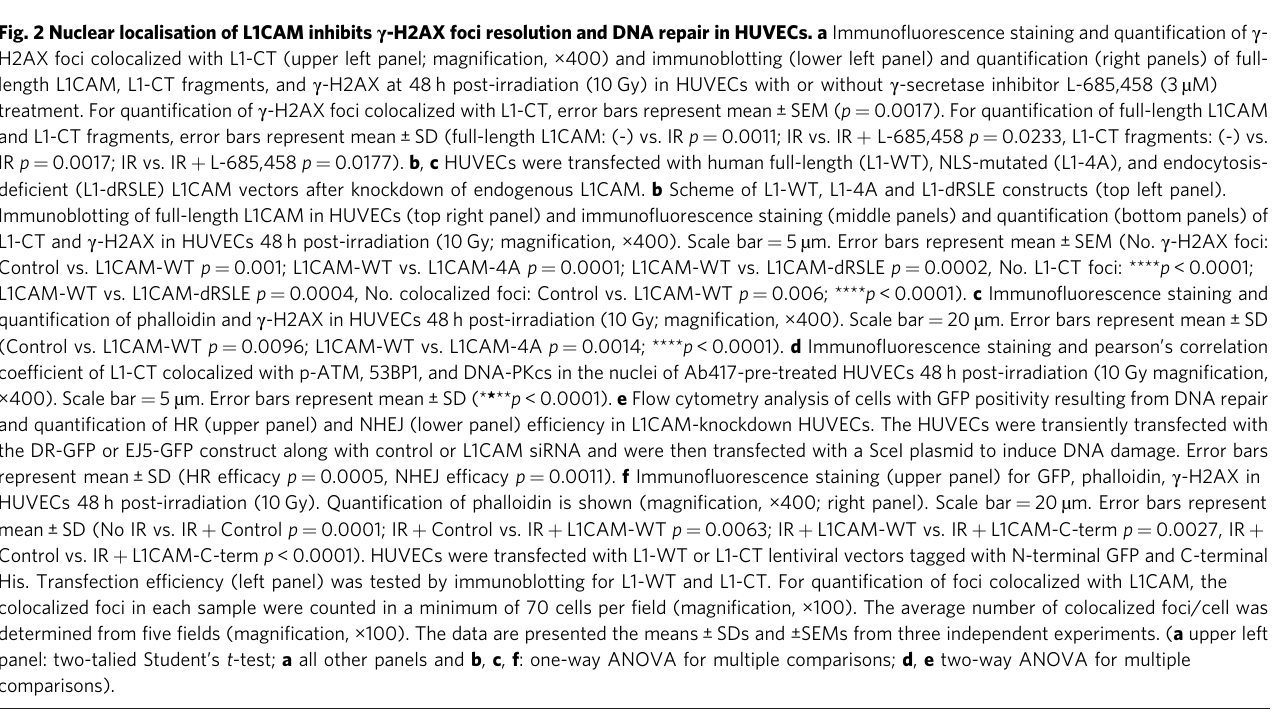
Fig. 2 Nuclear localisation of L1CAM inhibits γ -H2AX foci resolution and DNA repair in HUVECs. a Immuno fl uorescence staining and quanti fi cation of γ - H2AX foci colocalized with L1-CT (upper left panel; magni fi cation, ×400) and immunoblotting (lower left panel) and quanti fi cation (right panels) of full- length L1CAM, L1-CT fragments, and γ -H2AX at 48 h post-irradiation (10 Gy) in HUVECs with or without γ -secretase inhibitor L-685,458 (3 µ M) treatment. For quanti fi cation of γ -H2AX foci colocalized with L1-CT, error bars represent mean ± SEM ( p = 0.0017). For quanti fi cation of full-length L1CAM and L1-CT fragments, error bars represent mean ± SD (full-length L1CAM: (-) vs. IR p = 0.0011; IR vs. IR + L-685,458 p = 0.0233, L1-CT fragments: (-) vs. IR p = 0.0017; IR vs. IR + L-685,458 p = 0.0177). b , c HUVECs were transfected with human full-length (L1-WT), NLS-mutated (L1-4A), and endocytosis- de fi cient (L1-dRSLE) L1CAM vectors after knockdown of endogenous L1CAM. b Scheme of L1-WT, L1-4A and L1-dRSLE constructs (top left panel). Immunoblotting of full-length L1CAM in HUVECs (top right panel) and immuno fl uorescence staining (middle panels) and quanti fi cation (bottom panels) of L1-CT and γ -H2AX in HUVECs 48 h post-irradiation (10 Gy; magni fi cation, ×400). Scale bar = 5 µ m. Error bars represent mean ± SEM (No. γ -H2AX foci: Control vs. L1CAM-WT p = 0.001; L1CAM-WT vs. L1CAM-4A p = 0.0001; L1CAM-WT vs. L1CAM-dRSLE p = 0.0002, No. L1-CT foci: **** p < 0.0001; L1CAM-WT vs. L1CAM-dRSLE p = 0.0004, No. colocalized foci: Control vs. L1CAM-WT p = 0.006; **** p < 0.0001). c Immuno fl uorescence staining and quanti fi cation of phalloidin and γ -H2AX in HUVECs 48 h post-irradiation (10 Gy; magni fi cation, ×400). Scale bar = 20 µ m. Error bars represent mean ± SD (Control vs. L1CAM-WT p = 0.0096; L1CAM-WT vs. L1CAM-4A p = 0.0014; **** p < 0.0001). d Immuno fl uorescence staining and pearson ’ s correlation coef fi cient of L1-CT colocalized with p-ATM, 53BP1, and DNA-PKcs in the nuclei of Ab417-pre-treated HUVECs 48 h post-irradiation (10 Gy magni fi cation, ×400). Scale bar = 5 µ m. Error bars represent mean ± SD (* * ** p < 0.0001). e Flow cytometry analysis of cells with GFP positivity resulting from DNA repair and quanti fi cation of HR (upper panel) and NHEJ (lower panel) ef fi ciency in L1CAM-knockdown HUVECs. The HUVECs were transiently transfected with the DR-GFP or EJ5-GFP construct along with control or L1CAM siRNA and were then transfected with a SceI plasmid to induce DNA damage. Error bars represent mean ± SD (HR ef fi cacy p = 0.0005, NHEJ ef fi cacy p = 0.0011). f Immuno fl uorescence staining (upper panel) for GFP, phalloidin, γ -H2AX in HUVECs 48 h post-irradiation (10 Gy). Quanti fi cation of phalloidin is shown (magni fi cation, ×400; right panel). Scale bar = 20 µ m. Error bars represent mean ± SD (No IR vs. IR + Control p = 0.0001; IR + Control vs. IR + L1CAM-WT p = 0.0063; IR + L1CAM-WT vs. IR + L1CAM-C-term p = 0.0027, IR + Control vs. IR + L1CAM-C-term p < 0.0001). HUVECs were transfected with L1-WT or L1-CT lentiviral vectors tagged with N-terminal GFP and C-terminal His. Transfection ef fi ciency (left panel) was tested by immunoblotting for L1-WT and L1-CT. For quanti fi cation of foci colocalized with L1CAM, the colocalized foci in each sample were counted in a minimum of 70 cells per fi eld (magni fi cation, ×100). The average number of colocalized foci/cell was determined from fi ve fi elds (magni fi cation, ×100). The data are presented the means ± SDs and ±SEMs from three independent experiments. ( a upper left panel: two-talied Student ’ s t -test; a all other panels and b , c , f : one-way ANOVA for multiple comparisons; d , e two-way ANOVA for multiple